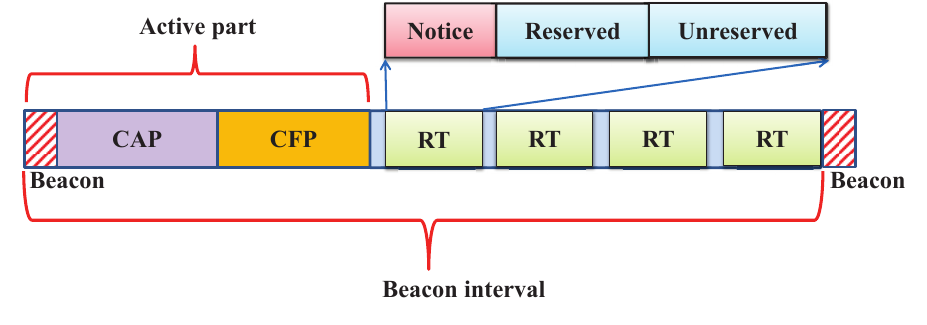
Figure 6. Proposed superframe structure.